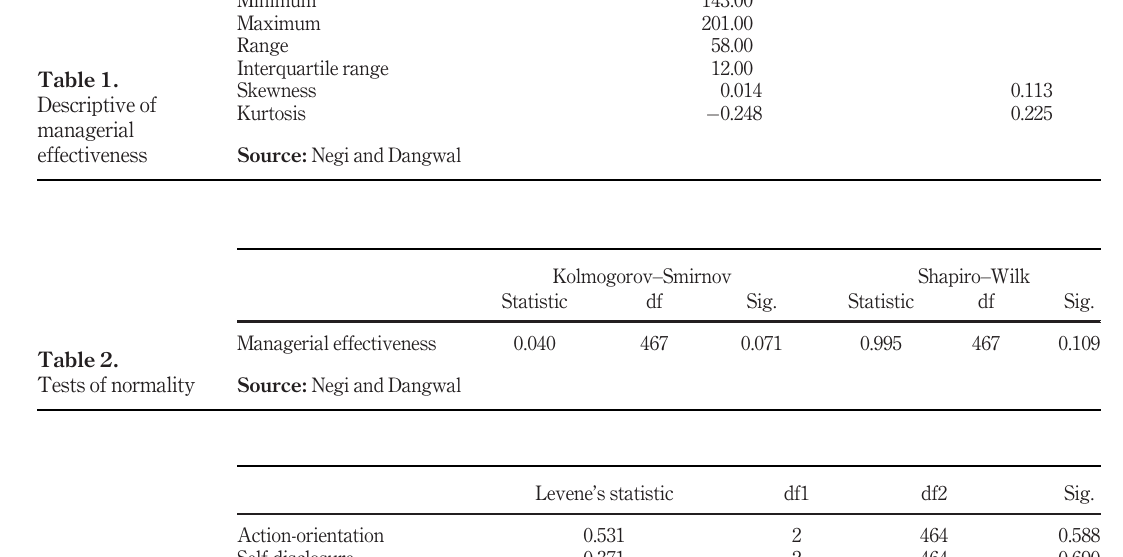
Table 3. Test of homogeneity of